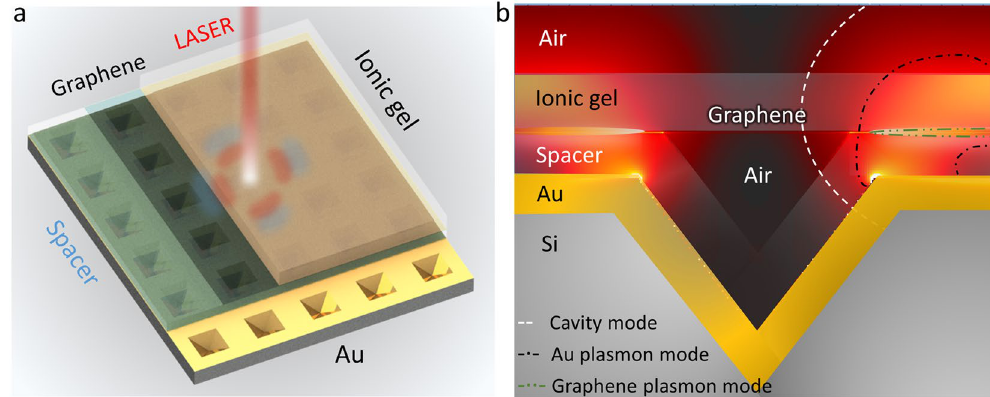
Figure 1. ( a ) Schematic of the device setup. ( b ) Artistic representation of the device operation showing the different electromagnetic field components in the